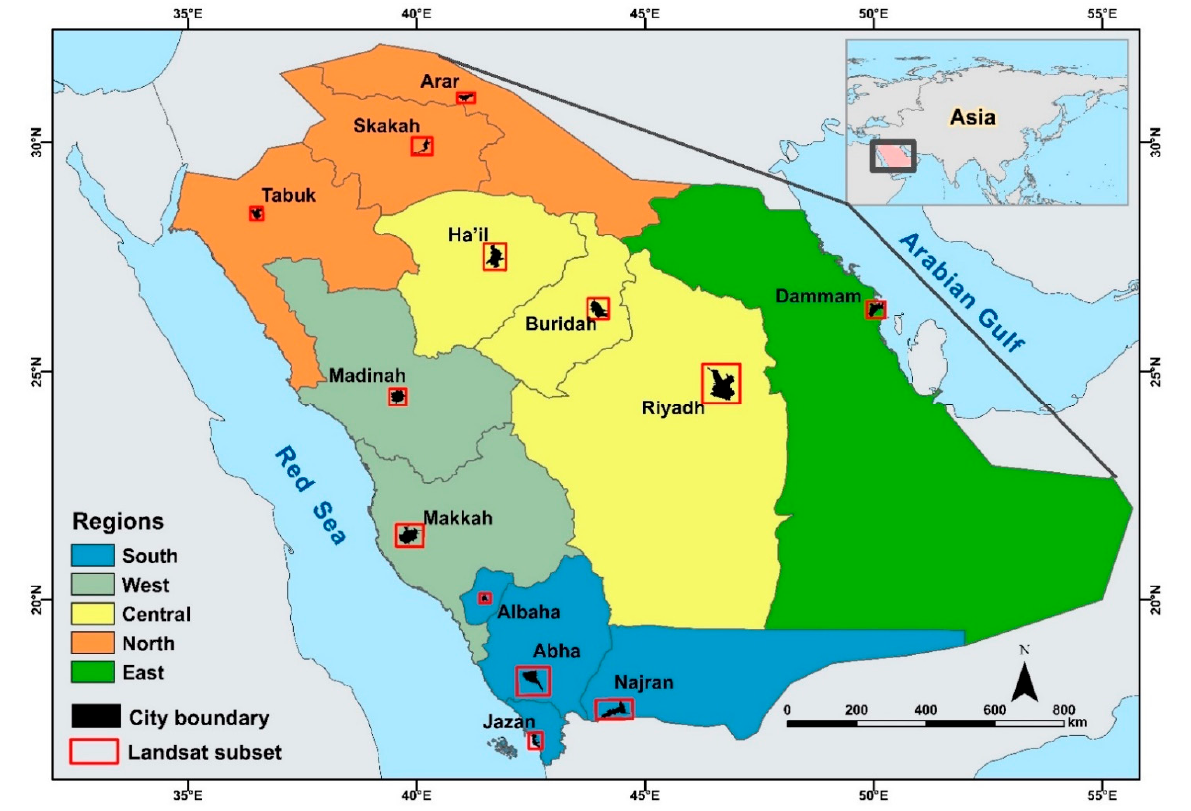
Figure 1. The 13 regions in Saudi Arabia and the geographic location of each region’s capital. The red squares/rectangles represent the subsets of Landsat boundaries that were employed in this research. The asymmetric black represents the boundary of each city.